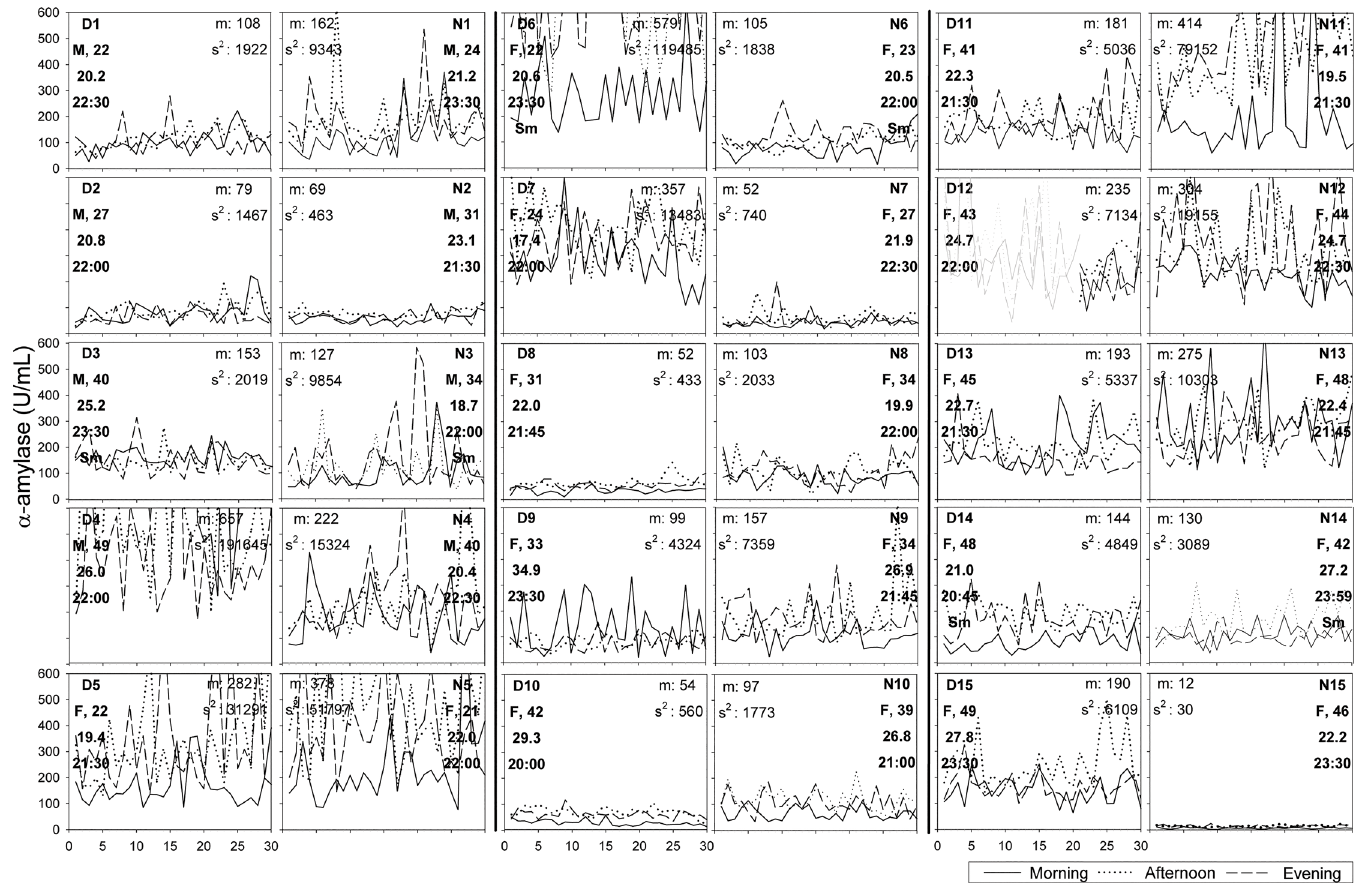
Fig 2. Alpha-amylase patterns over 30 days stratified by beep-time (morning, afternoon and evening values). Graphs of pair-matched individuals are placed alongside each other (e.g. D1 and N1). In the corner of the graphs the following information is displayed: identification number (D = depressed, N = non-depressed), gender (F = female, M = male), age in years, BMI, evening beep-time, and, if smoking ‘ Sm ’ . Descriptive statistics at the opposite side of the graphs display m, the mean of the series and s2, the variance of the